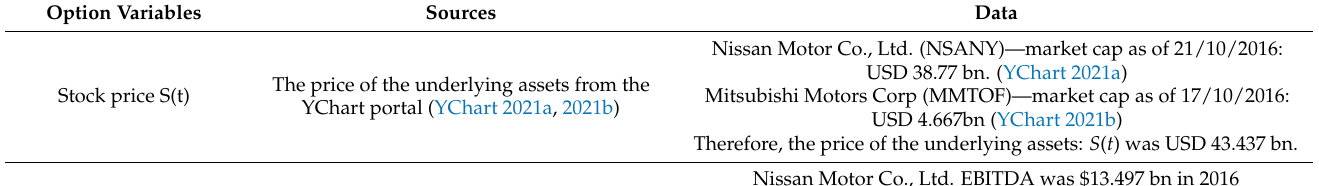
Table 3. Real option variables: sources and